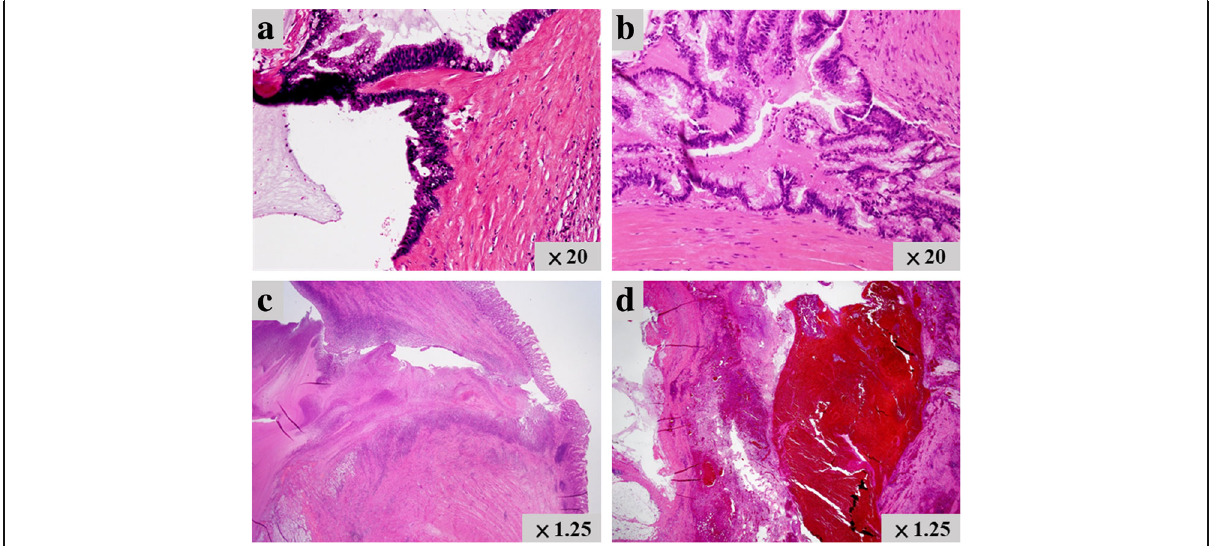
Fig. 4 Microscopic findings of the resected specimen. a Cancer cells were detected in the epithelium of the main pancreatic duct, though there were no signs of invasion. b Adenoma was identified on the remaining part of the epithelial cells of the pancreatic duct. c A gastropancreatic fistula was microscopically detected, and no cancer cells were detected on the area. d Microscopic examination identified a splenopancreatic fistula where no cancer cells were